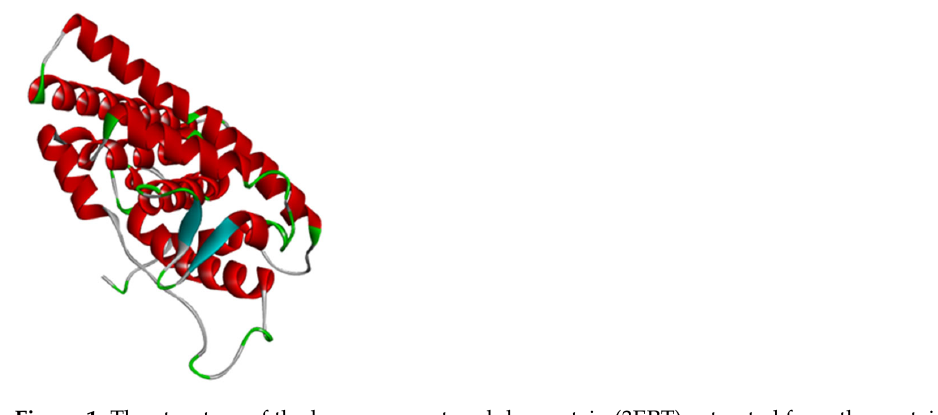
Figure 1. The structure of the human receptor alpha protein (3ERT) extracted from the protein data bank after removing water molecules and cocrystallized ligand molecules.